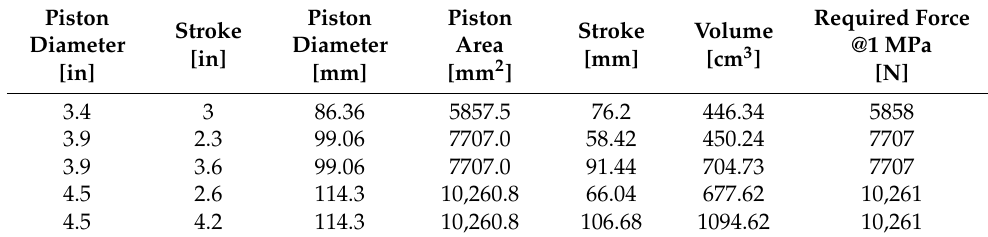
Table 2. Controlair actuator available dimensions.